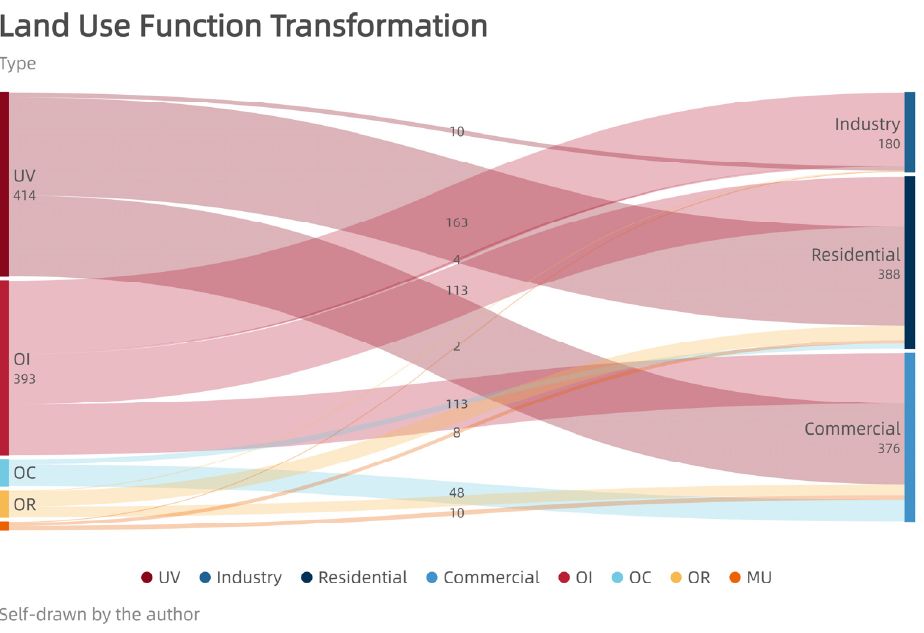
Figure A4. Land use change of implemented UR projects in Shenzhen. UV= urban villages, OI = old industrial area, OC = old commercial area, OR = old residential area, and MU = mixed-used area.